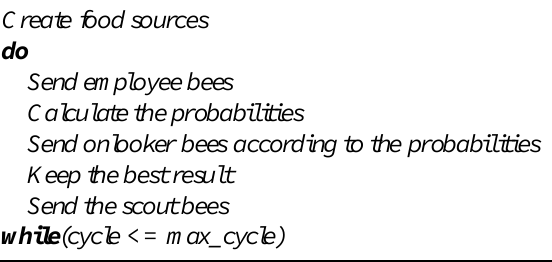
Figure 3. The procedure of the artificial bee colony (ABC)